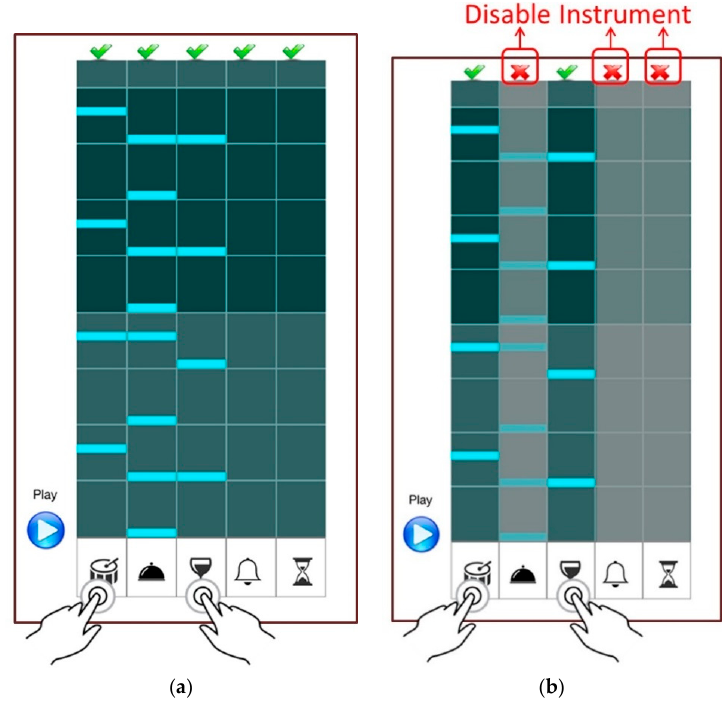
Figure 6. Rhythm rating function: ( a ) full instruments; ( b ) disable three instruments.